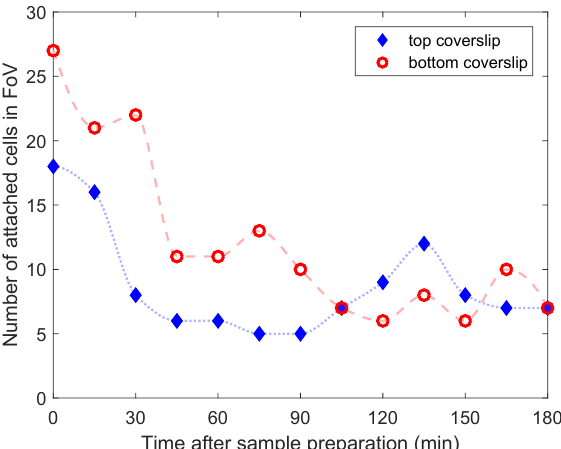
Figure 1. Number of attached cells in the FoV as a function of the time since sample preparation. The filled diamonds indicate the cell counts on the top coverslip, while the empty circles are for those on the bottom